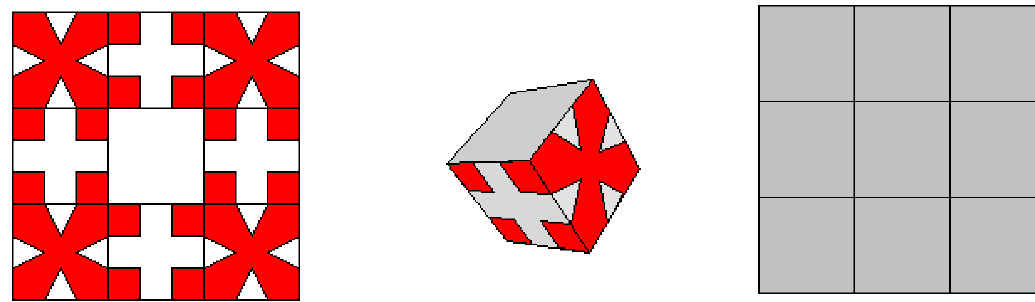
Figure 5. A screenshot of this hypothetical videogame showing the pattern to recreate ( left ); the cube with which the player interacts ( middle ); and the working space in which a copy of the pattern is created ( right